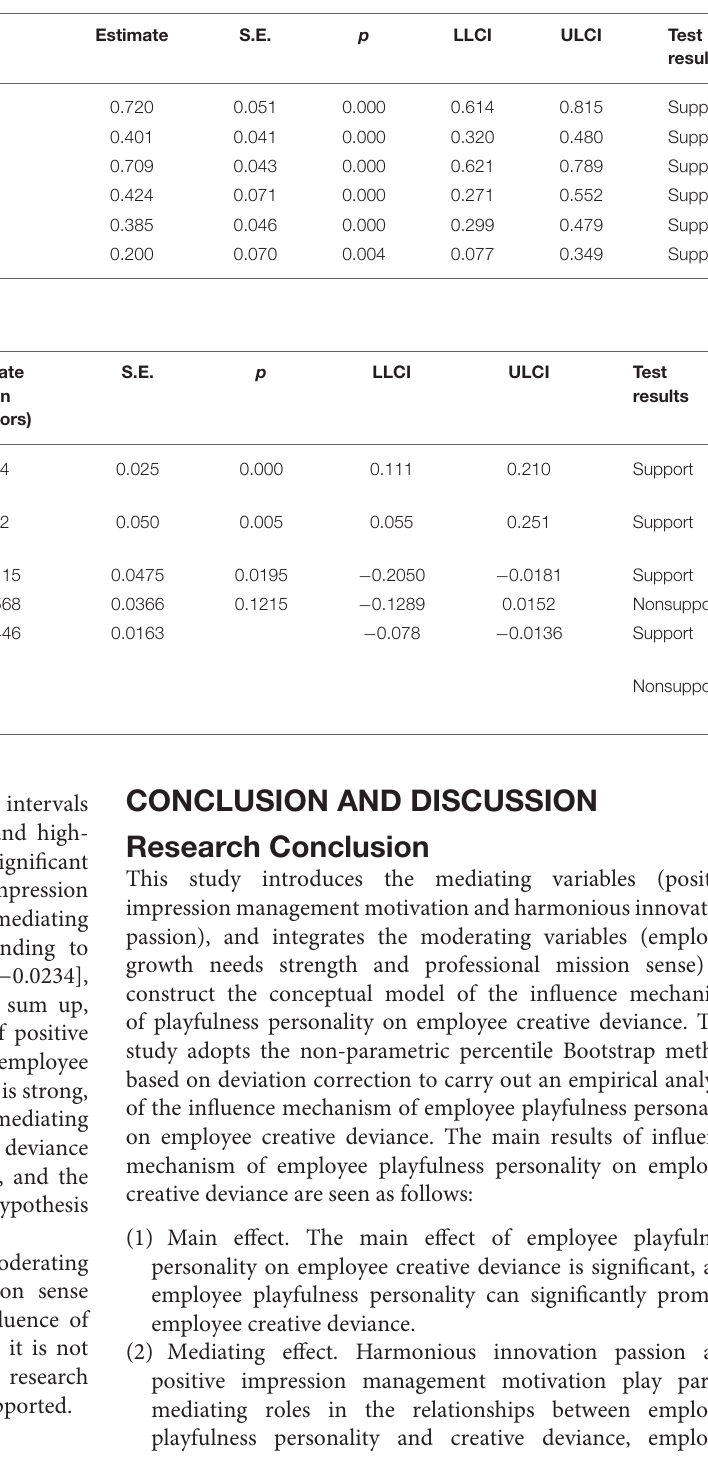
TABLE 17 | Research hypothesis test results summary 1.